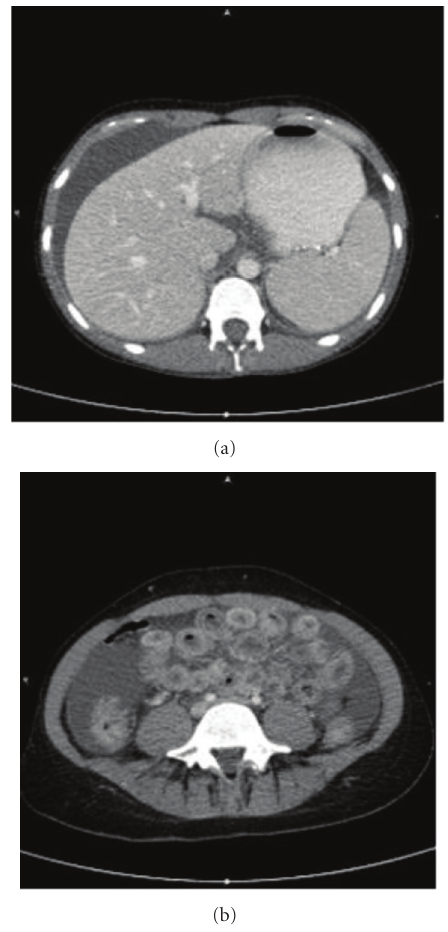
Figure 1: Computed tomography of abdomen and pelvis showing large amount of ascites and thickened small bowel wall. No pelvis or peritoneal mass identified.